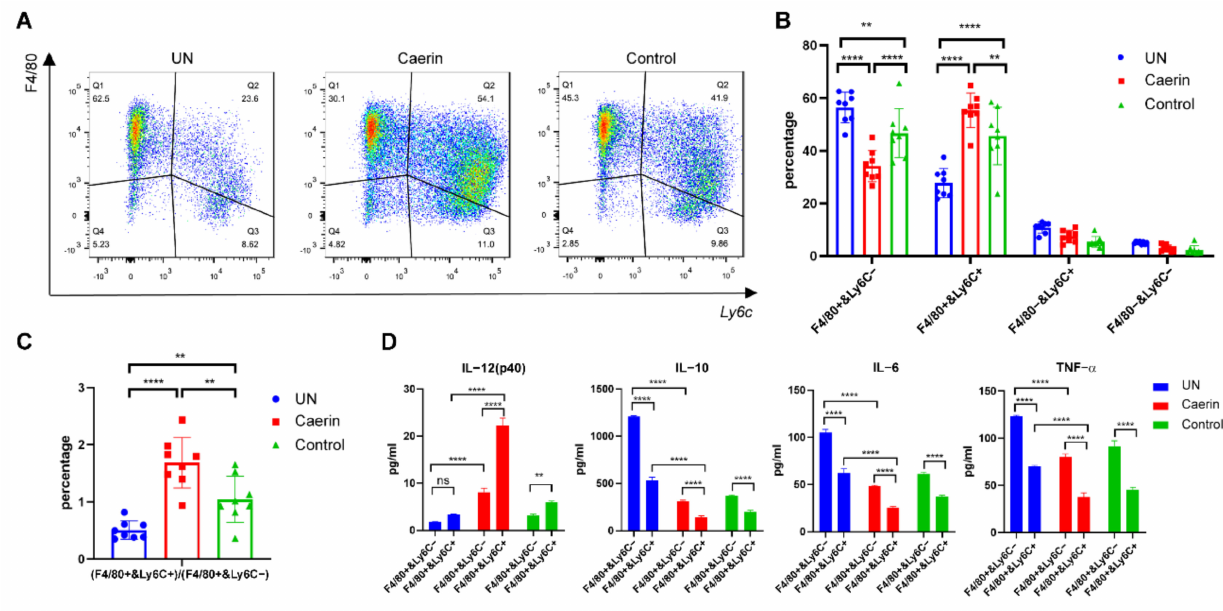
Figure 1. Mice receiving vaccination and ICB (Double Therapy, DT) immunotherapy plus caerin 1.1/1.9 have fewer F4/80+Ly6C − and more F4/80+Ly6C+ macrophages. After three days of